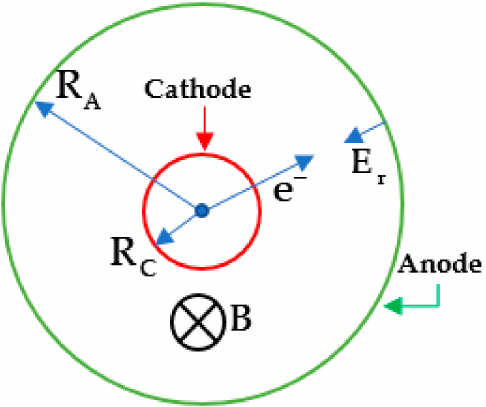
Figure 3. An electron’s motion in an electromagnetic